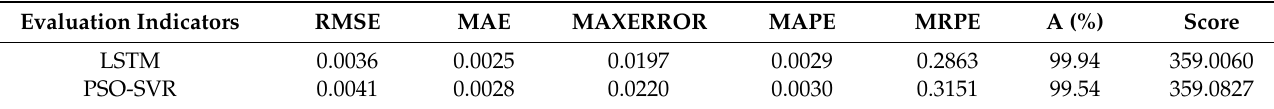
Table 1. Evaluation indicators for the prediction results of the two prediction models.